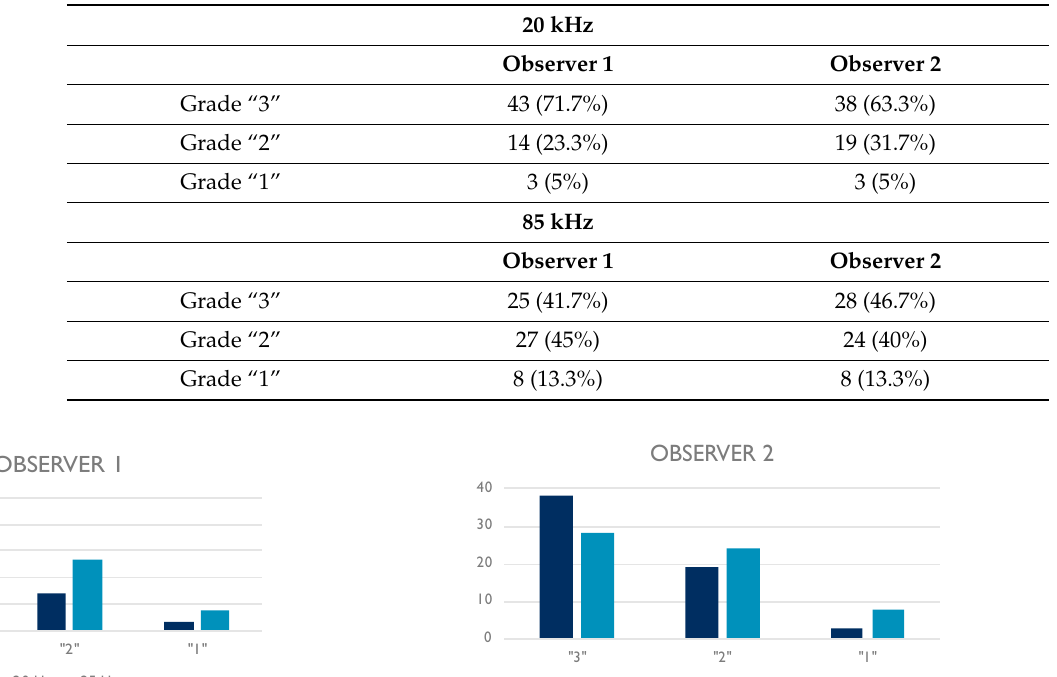
Table 3. Quality assessment values provided by the two observers for the 20 kHz images and 85 kHz images.